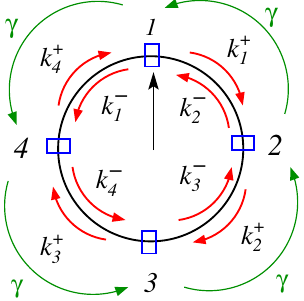
FIG. 3. Effective network for a clock driven by an external protocol that changes at stochastic times with N ¼ 4 states. The green backward arrows represent a jump with rate γ ¼ N= τ . A backward jump is equivalent to a forward rotation of the rates represented in Fig. 2.